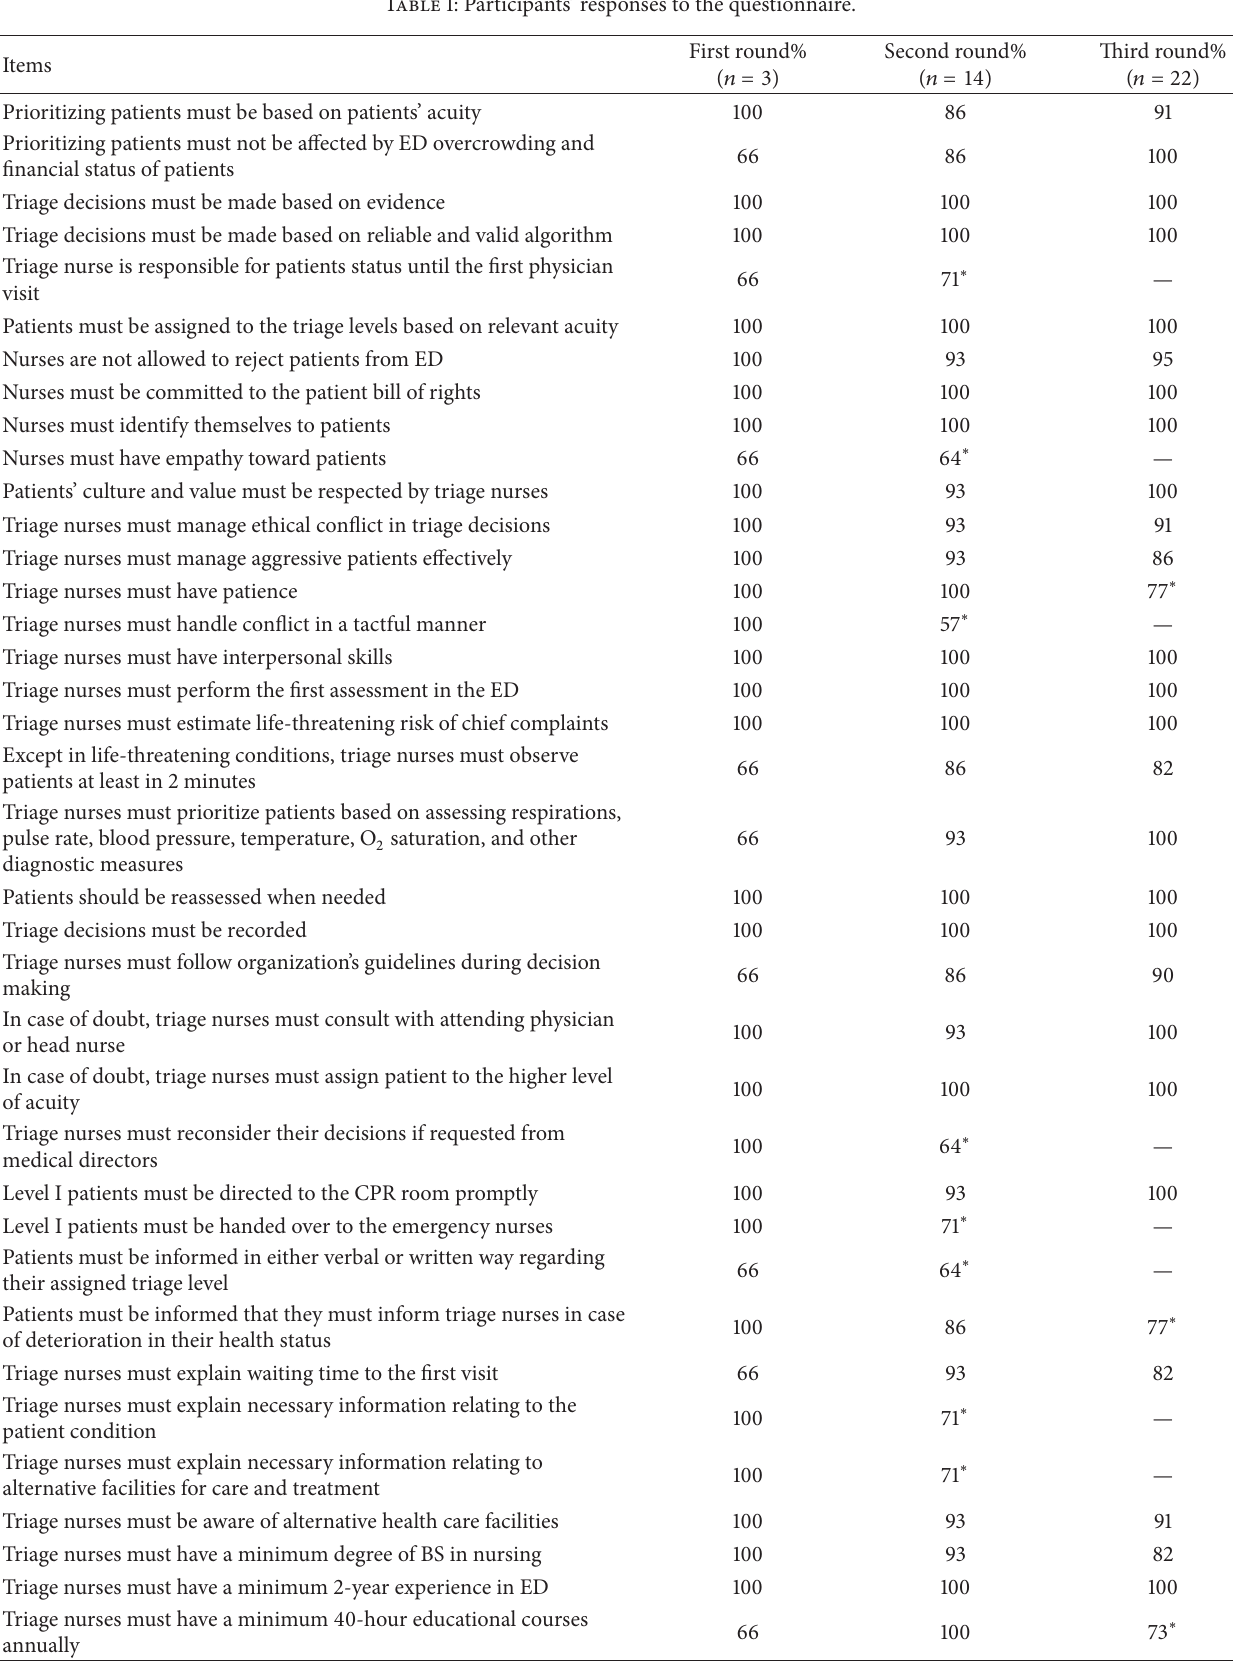
Table 1: Participants’ responses to the